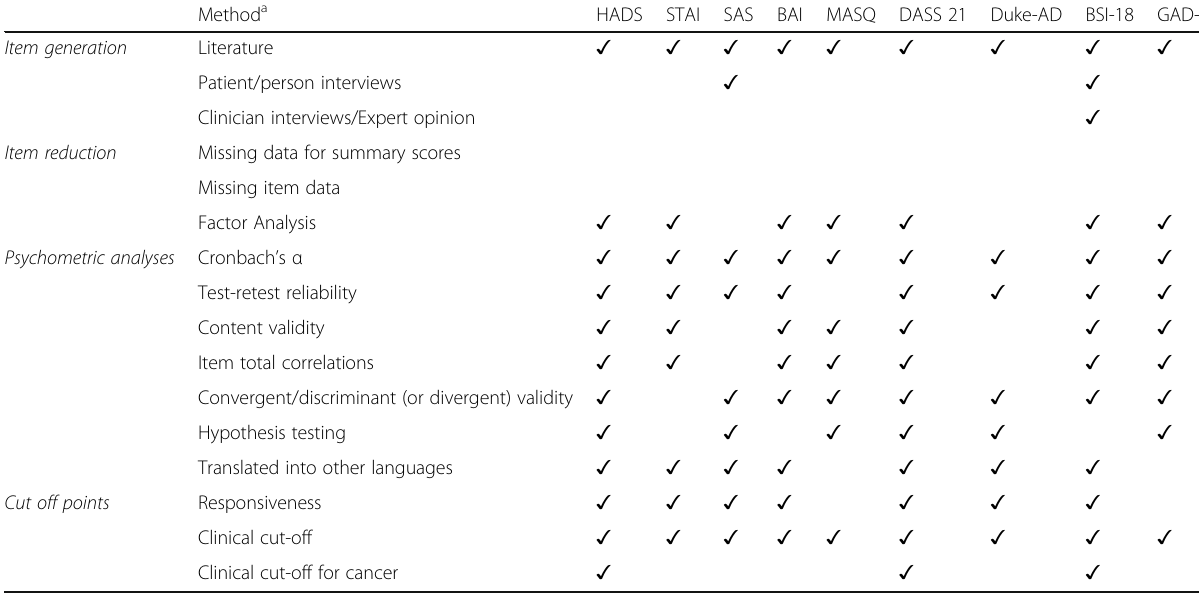
Table 3 Patient reported outcome measures of anxiety: measurement properties